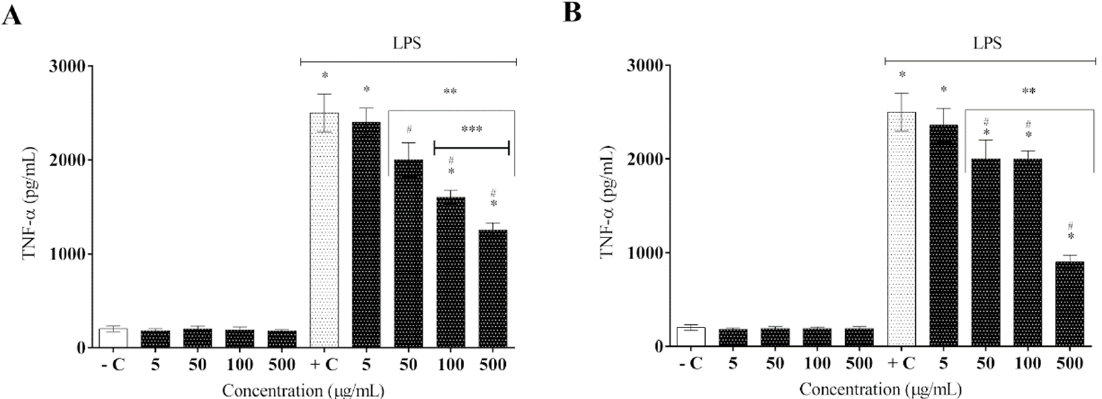
Figure 4. Effect of L. rigida extracts on TNF- α cytokine release: ( A ) AELR and ( B ) HELR. The cytokine content was released in RAW 264.7 cells and stimulated by LPS after 24 h. Release of cytokines was quantified by ELISA analysis. Data represent the mean ± SEM from three independent experiments. One-way ANOVA was used followed by a post hoc Tukey test. * p < 0.05 vs. the negative control group; # p < 0.05 vs. the LPS-stimulated cells; ** p < 0.05 between the concentrations of the extract;